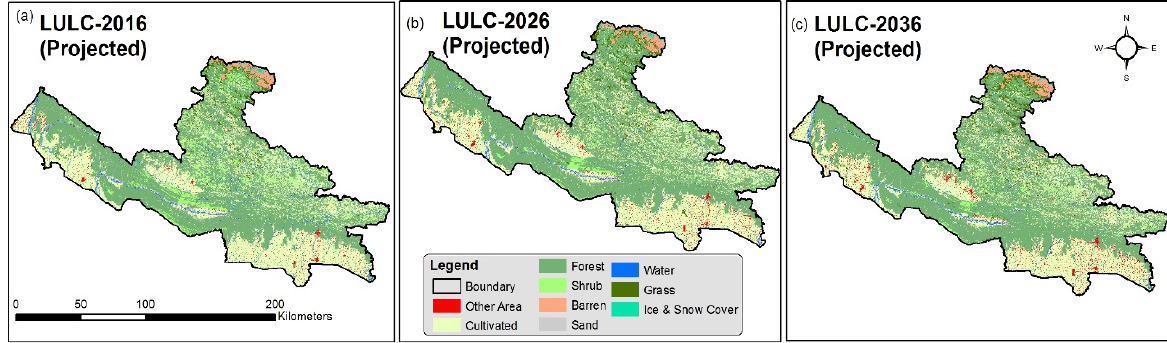
Figure 7. LC-Projected map of Lumbini Province: ( a ) 2016; ( b ) 2026; ( c ) 2036.